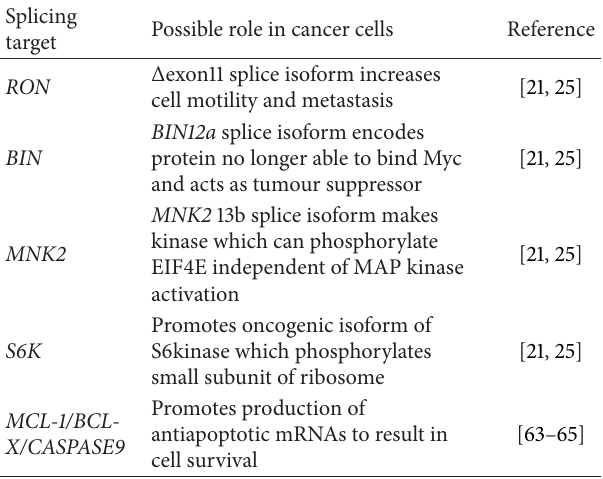
Table 1: Known prooncogenic splicing targets of SFRS1 (previously known as